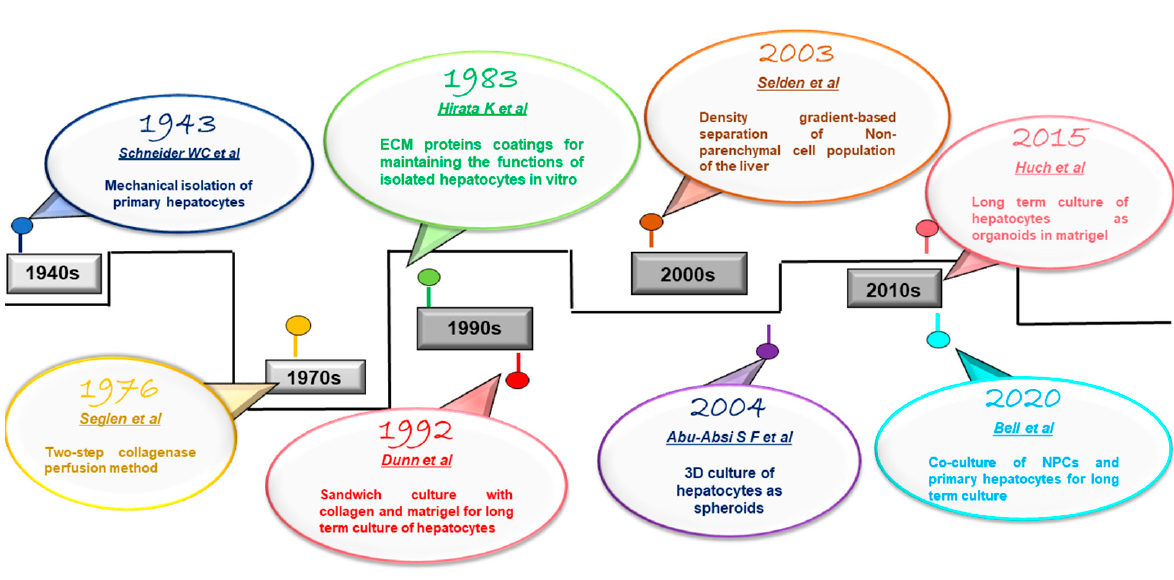
Figure 3. Major milestones in the isolation and culture of primary hepatocytes and non-parenchymal cell population of the liver [29,30,46,58,61–64].